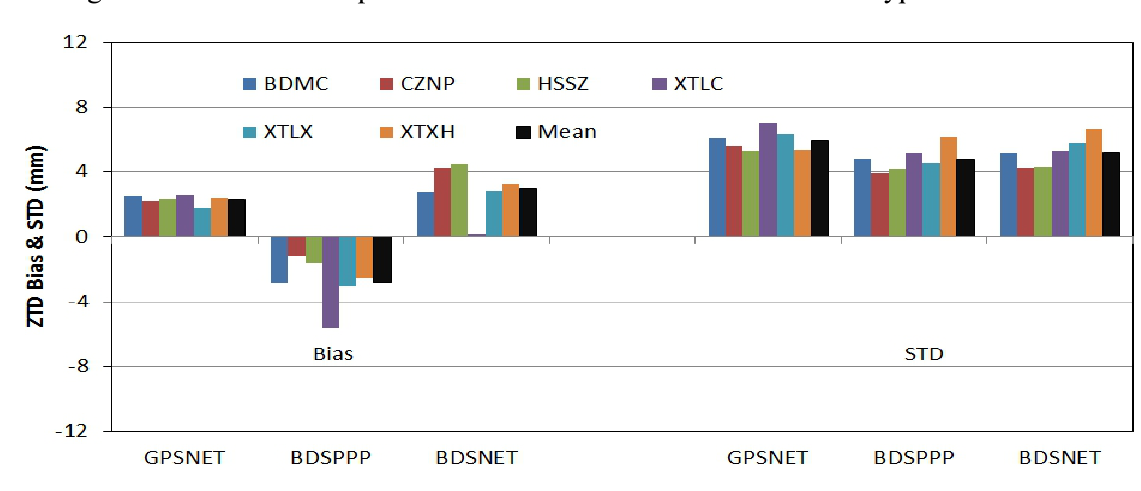
Figure 6. Bias ( left ) and STD ( right ) of ZTD derived at the six local stations from GPSNET, BDSPPP, and BDSNET compared with that derived from GPSPPP solution. The averaged Bias and STD are plotted in black at the end of each solution type.